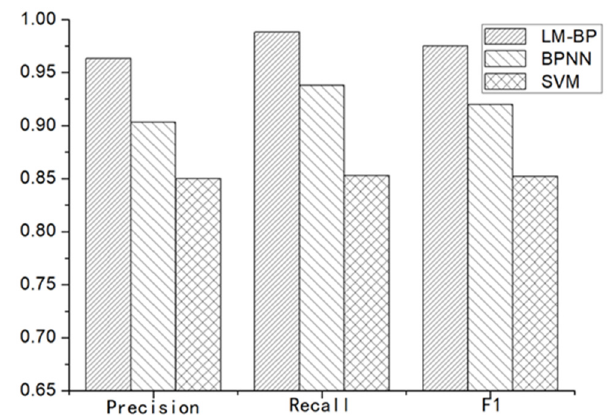
Figure 21. Accuracy comparison for obstacle recognition using Levenberg–Marquardt back-propagation (LM-BP), back-propagation neural network (BPNN) and support vector machine (SVM).